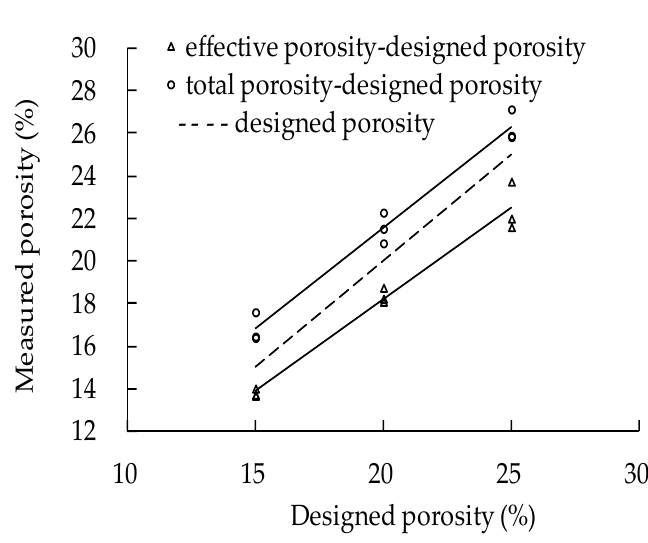
Figure 5. Relationship between measured porosity and designed porosity.